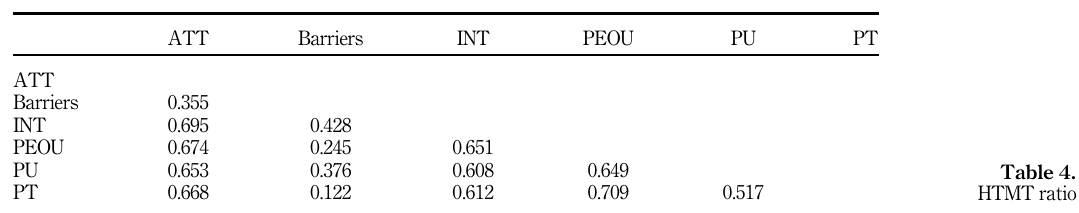
Table 3. Fornell-Larcker criterion